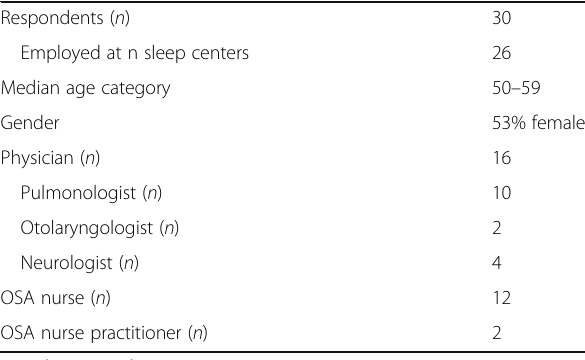
Table 2 Healthcare professional survey respondent